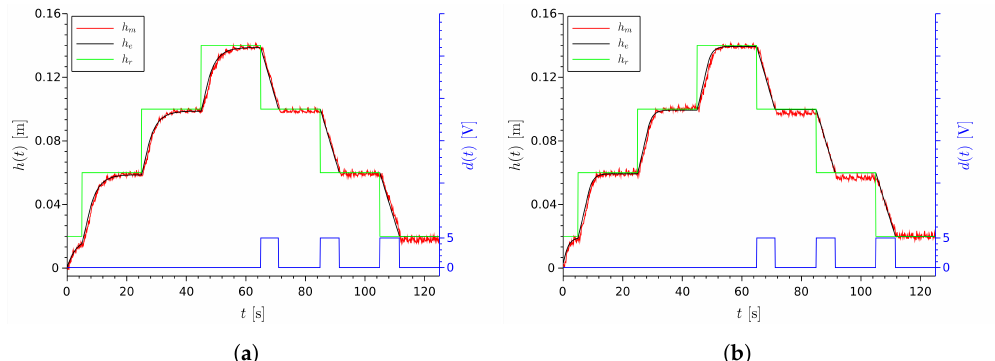
Figure 10. Time histories of the pyramid-shaped step responses of the hybrid P-controller-based closed-loop control system with a numerical prediction of the reference input h r ( t ) . Opening of the solenoid valve at d ( t ) operates as the control input, allowing for emptying of the tank. ( a ) h ( 0 ) = 0, k p = 200. ( b ) h ( 0 ) = 0, k p =